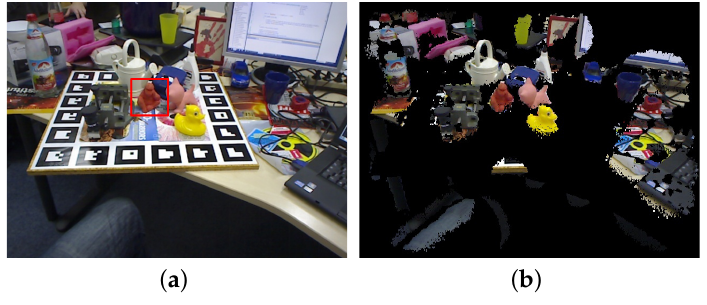
Figure 2. Illustration of scene preprocessing. ( a ) original image containing all scene points. The detection target is in the red bounding box; ( b ) the image after preprocessing. The black points are removed scene points while the color points are reserved points for